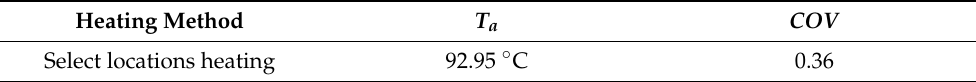
Table 4. T a and COV after heating at select locations (material: